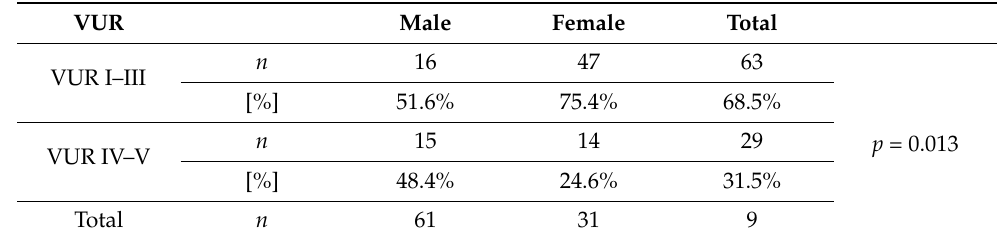
Table 3. Number of children with VUR depending on